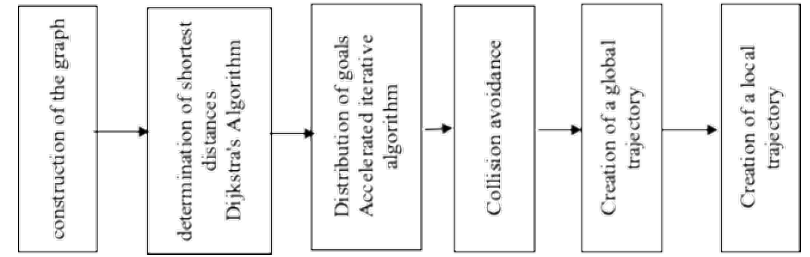
Fig. 2. Program's algorithm for solving the set